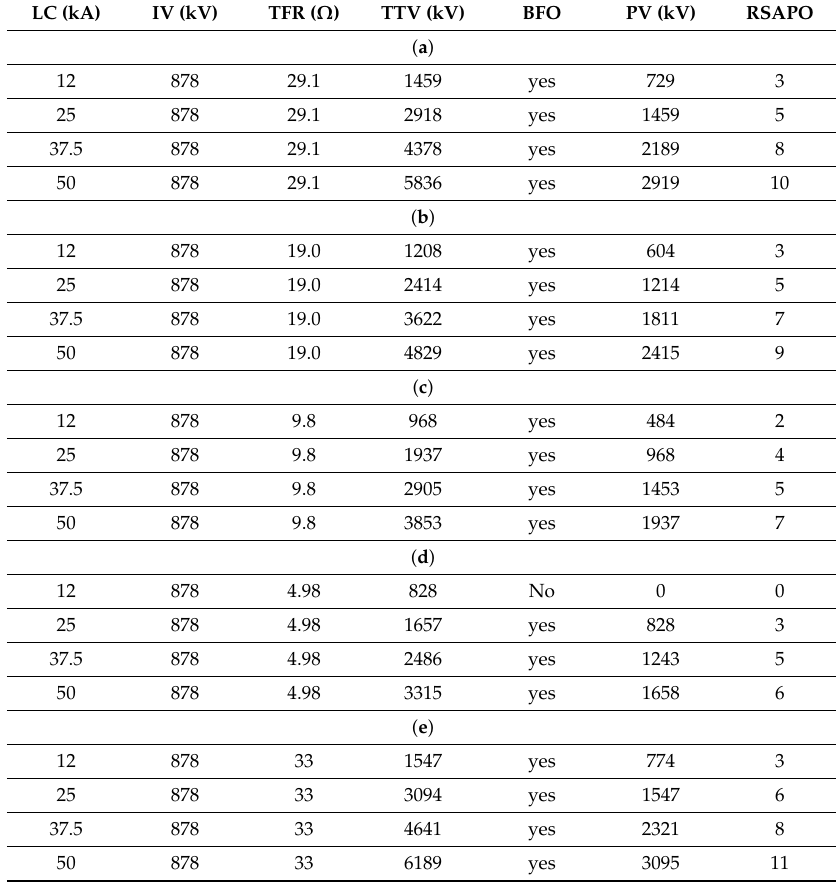
Figure 20. Lightning overvoltages vs. tower number — the influence of surge line arrestors. Table 5 shows the number of surge arrestors needed to drain lightning strokes of different magnitude and soil parameters from over-voltages into the soil. The soil parameters of 1000 Ω-m and 500 Ω-m for the lower layer have been extracted from the analysis of cases used. Table 5. ( a ): Resistance at the tower footing of 29.1 and various strokes of lightning. ( b ): Resistance at the tower footing of 18.7 and various strokes of lightning. ( c ): Resistance at the tower footing of 9.8 and various strokes of lightning. ( d ): Resistance at the tower footing of 4.98 and various strokes of lightning. ( e ): Resistance at the tower footing of 33 and various strokes of lightning. PV – Phase Voltage; RSAPO – required time in South Africa to respond to the power outage.